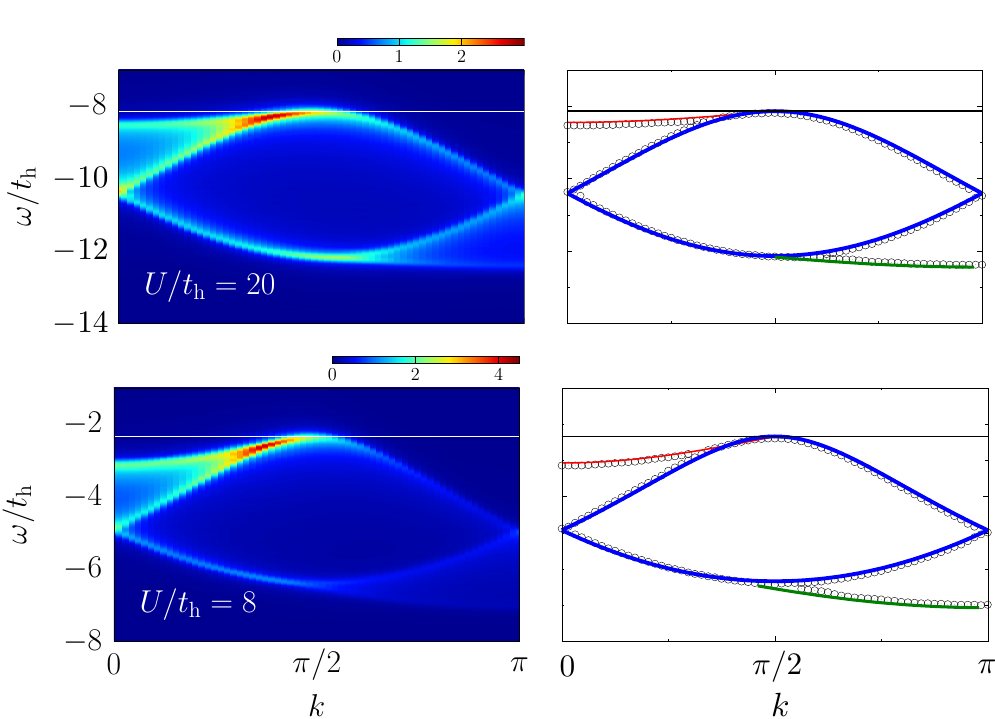
Figure 7: Photoemission spectra in the strong-coupling regime of half-filled 1D Hub- = 20 (top) and 8 (bottom). Results in the left panels and bard model with U / t h symbols in the right panels are obtained by t-DMRG. The blue (red) line denotes the holon (spinon) branch, the green line gives the lower onset of the spinon-holon excitation continuum according to the Bethe-ansatz solution in the thermodynamic limit (9)-(13). The white and black horizontal lines indicate half of the single-particle / 2 t gap − ∆ . c h